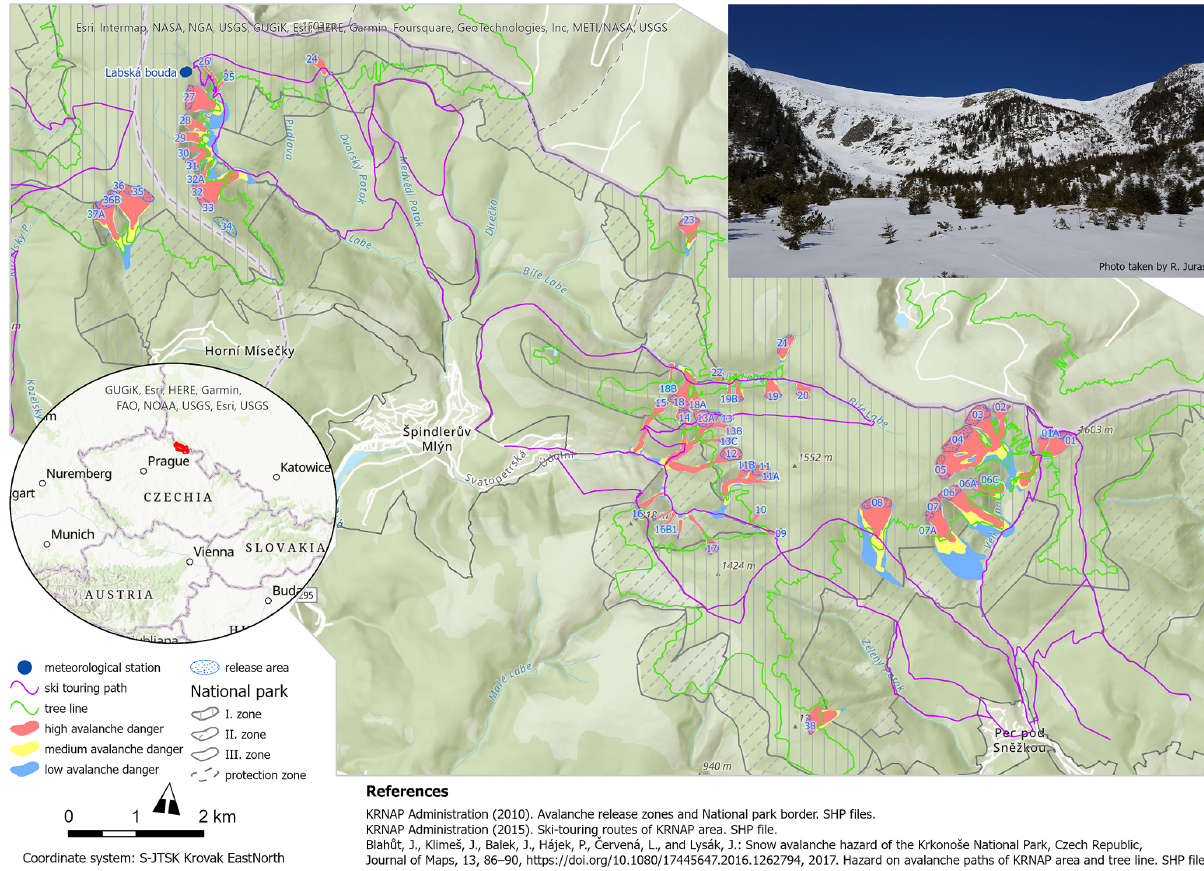
Figure 1. Study location of avalanche activity in the Krkonoše